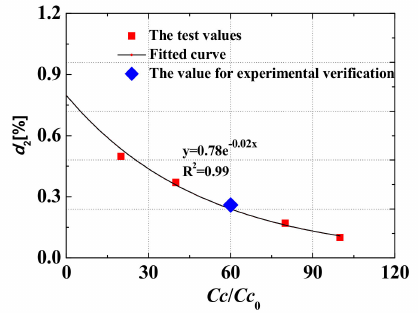
Figure 15. The relationship between the parameter d 2 and cement content Cc